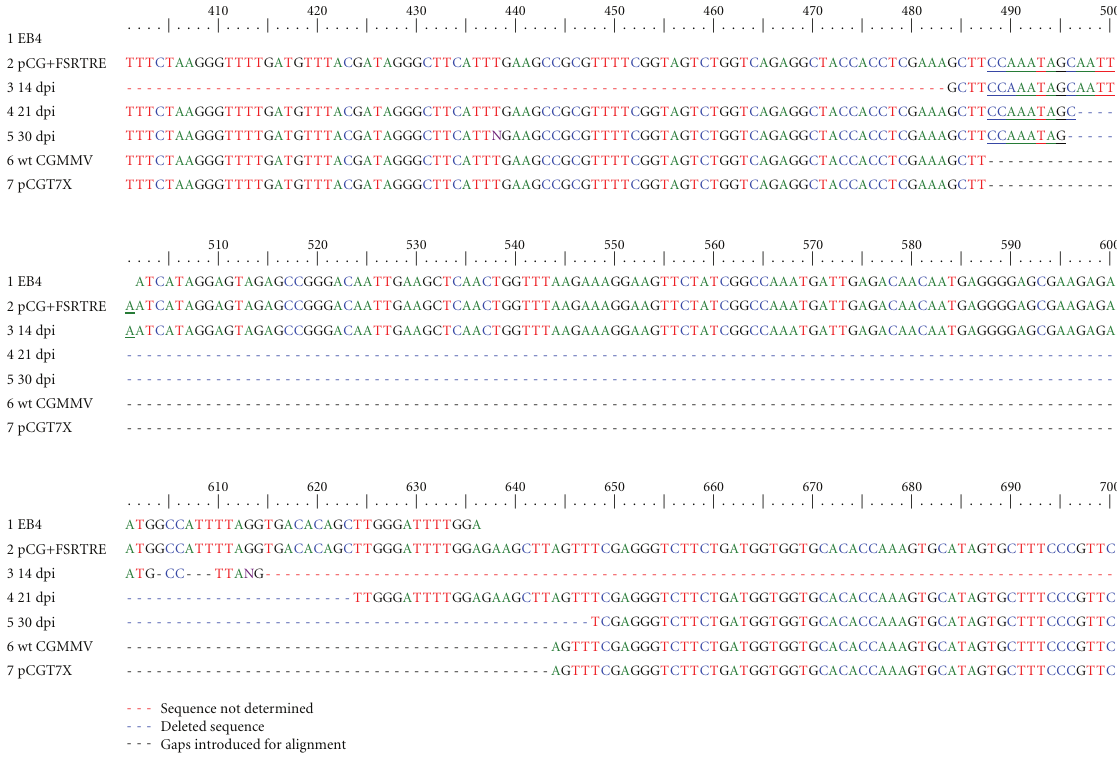
Figure 6: Sequence analyses of RT-PCR-amplified products from putative chimeric CGMMV RNA at di ff erent days postinoculation (dpi). The sequenced alignment shows that EB4 sequence was truncated and not complete after 21dpi. The putative chimeric CGMMV produced did not express the EB4 and its genome resembled the wild-type CGMMV. Introduced read-through sequences and extra codons are underlined. Complete EB4 sequence is aligned accordingly with the other